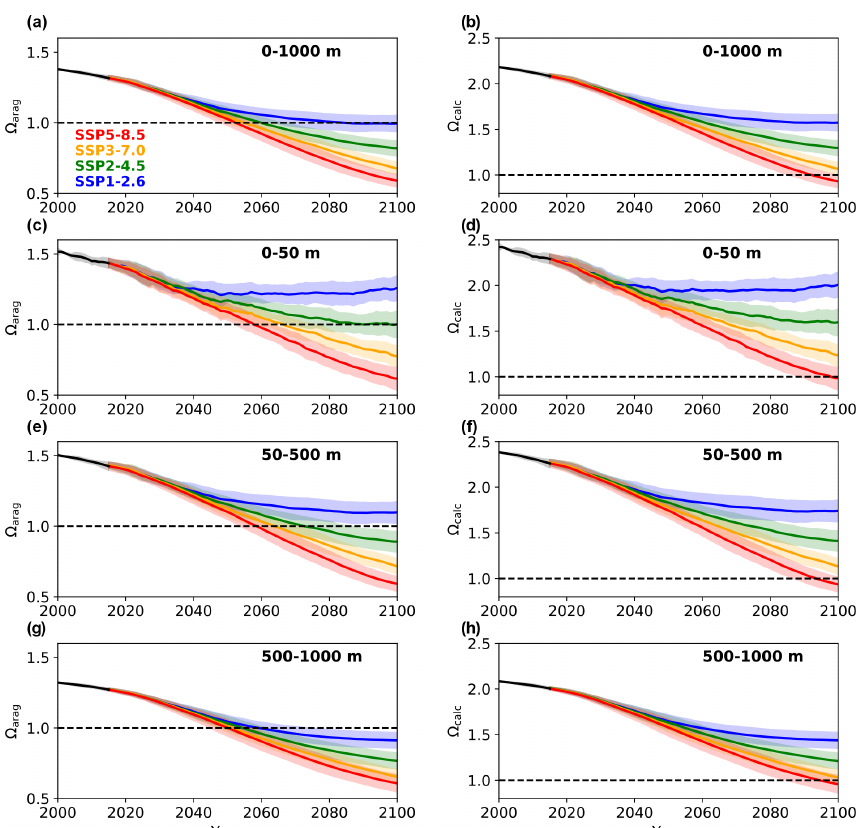
Figure 3. Basin-wide Arctic Ocean calcium carbonate saturation states over the 21st century. Time series of multi-model mean basin-wide saturation states of aragonite from 2000 to 2014 (black) and from 2015 to 2100 for SSP1-2.6 (blue), SSP2-4.5 (green), SSP3-7.0 (orange), and SSP5-8.5 (red) averaged (a) from 0 to 1000m, (c) from 0 to 50m, (e) from 50 to 500m, and (g) from 500 to 1000m with ± 1SD ( n = 12–14) shown as a shaded area. The differences when changing from historical simulations to the SSPs result from the different number of ensemble members that are available for each simulation. (b, d, f, h) The same time series but for